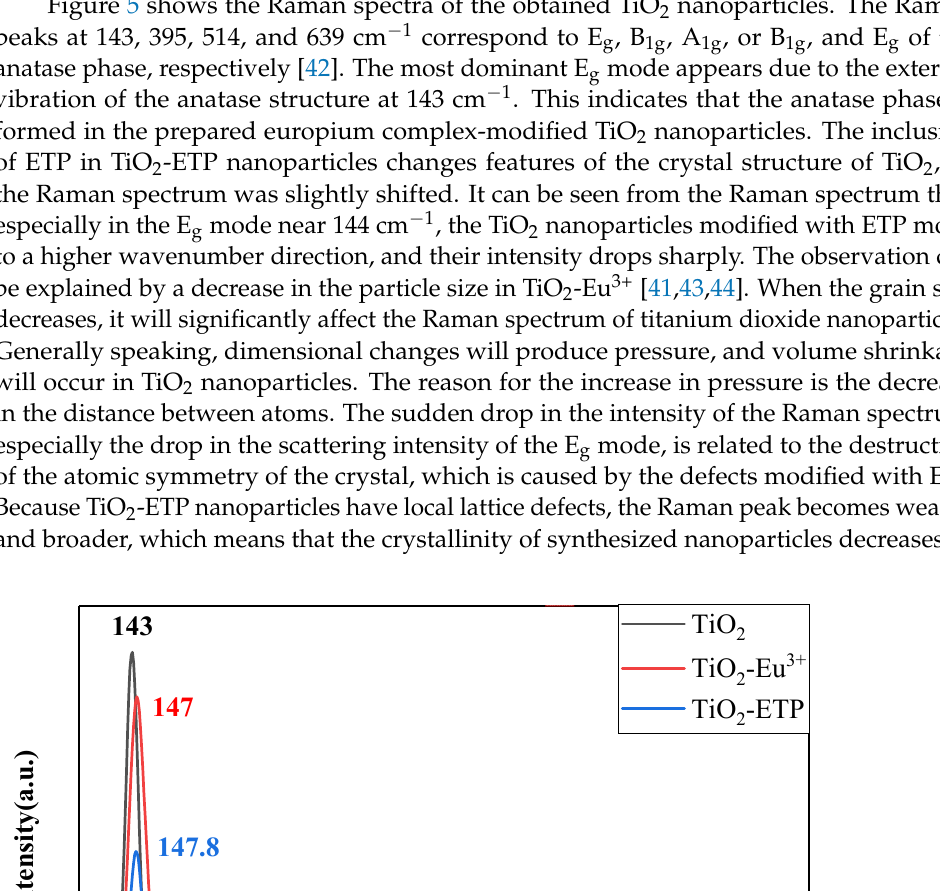
3+ , and TiO 2 , TiO 2 -Eu 2